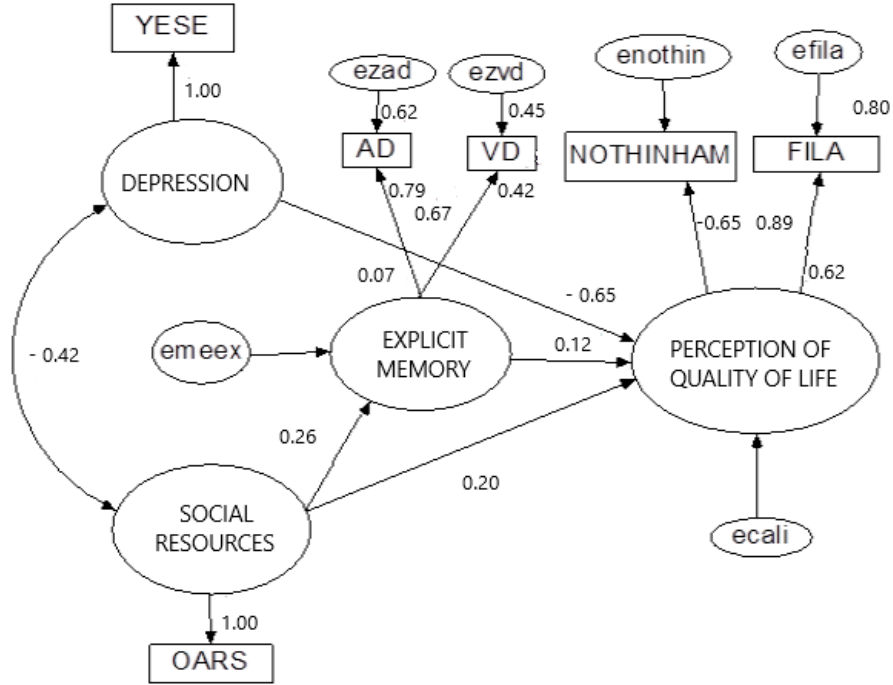
Figure 1. Active aging model. Relationship of social resources, depression, explicit memory and perception of quality of life. Source: Self-made. Note: Main goodness-of-fit indices in the active aging model: χ 2 (6, N = 128) = 7.708, p = 0.9260; normal fit index = 0.992; comparative fit index (CFI) = 1.00; root-mean-square error of approximation (RMSEA) = 0.00; goodness of fit = 1.00; adjusted goodness of fit = 0.997; ezvd = Error; ezad = Error; VD = delayed visual index; AD = delayed auditory index; YESE = Yesavage’s Geriatric Depression Scale (Yesavage, 1986); FILA = Philadelphia Scale of Satisfaction; OARS = Social Resources Scale; ecali = Error; NOTHINHAM = Nottingham Health Profile (NHP); enothin = Error. Estimate, SE, CR, P, Label data and Model Fit Summary are available in Supplementary